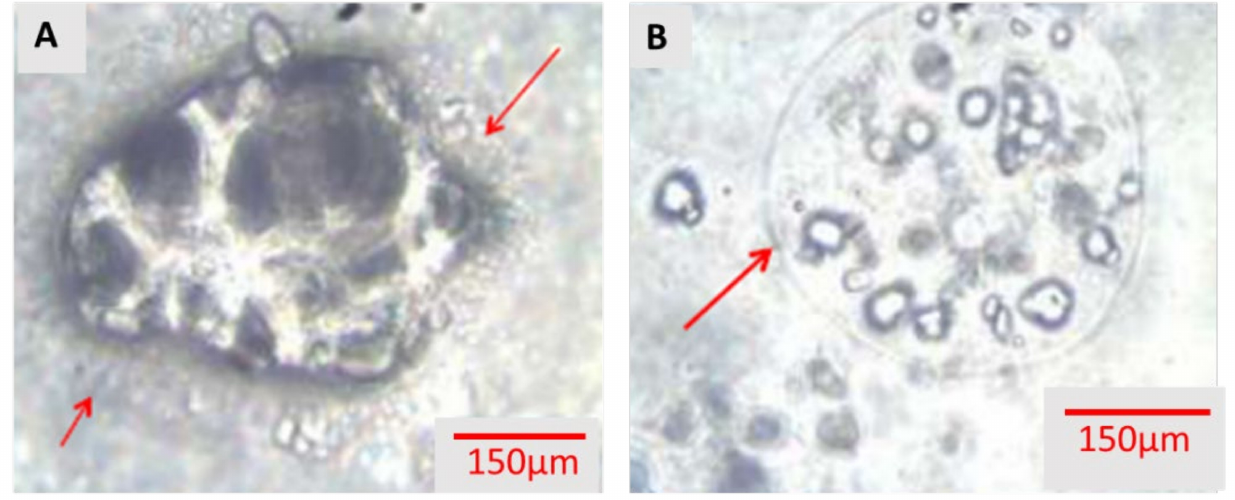
Figure 3. Light microscopic morphology of microbead encapsulation of Lactobacillus acidophilus ATCC 4356 probiotic by ( A ) modified citrus pectin alginate showing the chitosan coating effect (red arrow) and ( B ) sodium alginate particles produced by modified emulsification